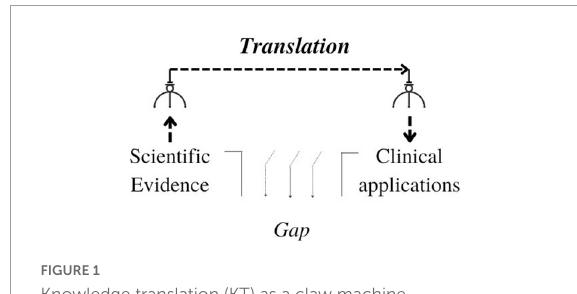
FIGURE1 Knowledge translation (KT) as a claw